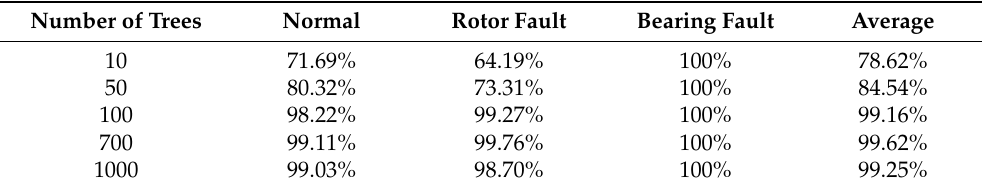
Table 11. Diagnostic accuracy of XGBoost through two-fold cross-validation.